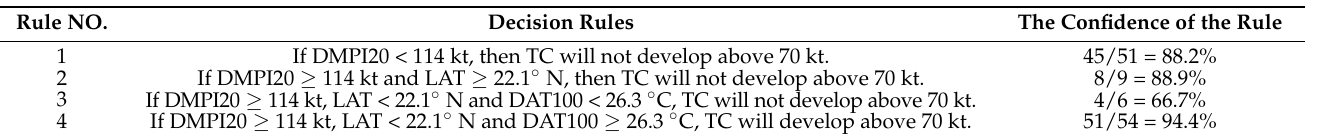
Table 3. Description and the confidence of the rule of the developed decision tree. Note that all variables here were averaged along the TC track from genesis to 3.25 days.